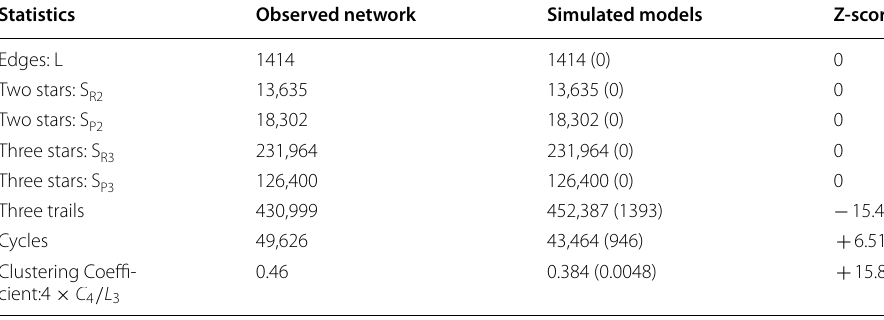
For the simulation models, numbers in the parentheses are standard deviations and number outside the parentheses are mean values